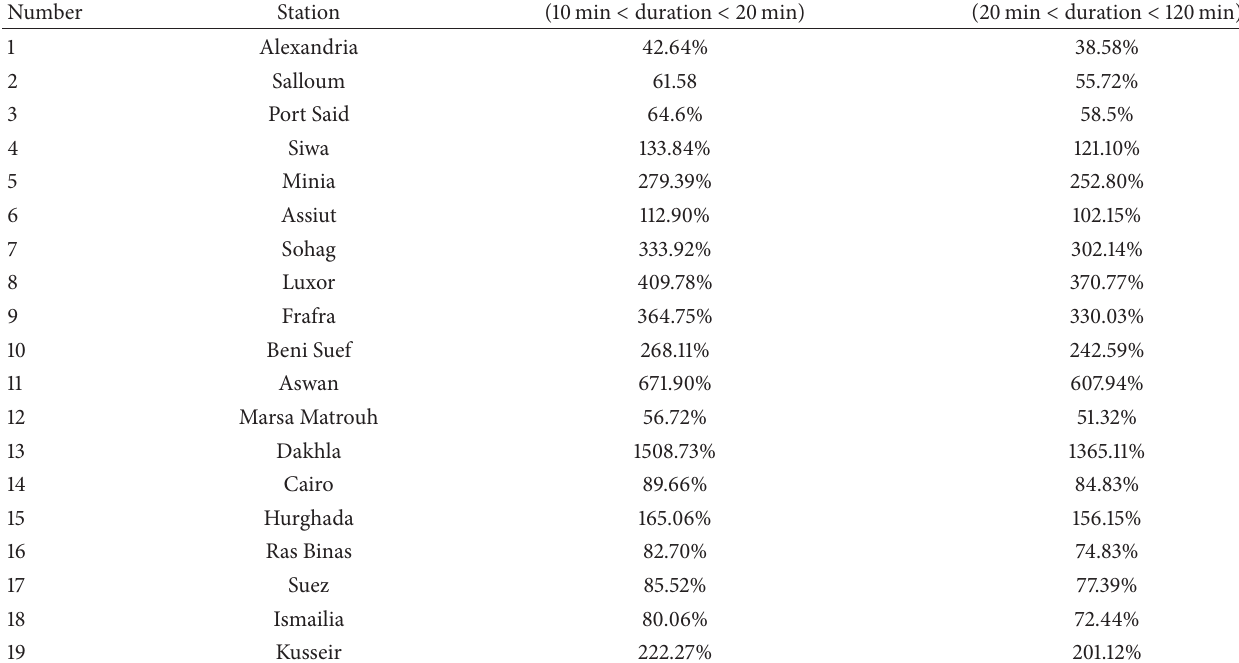
Table 5: The percentage between the Egyptian code’s equations and the proposed equations.